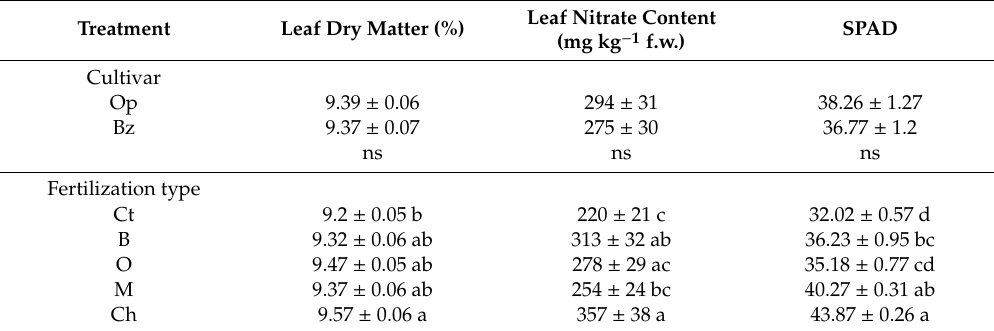
Table 3. Dry matter, nitrate content and SPAD of basil leaves as a ff ected by cultivar and fertilization.